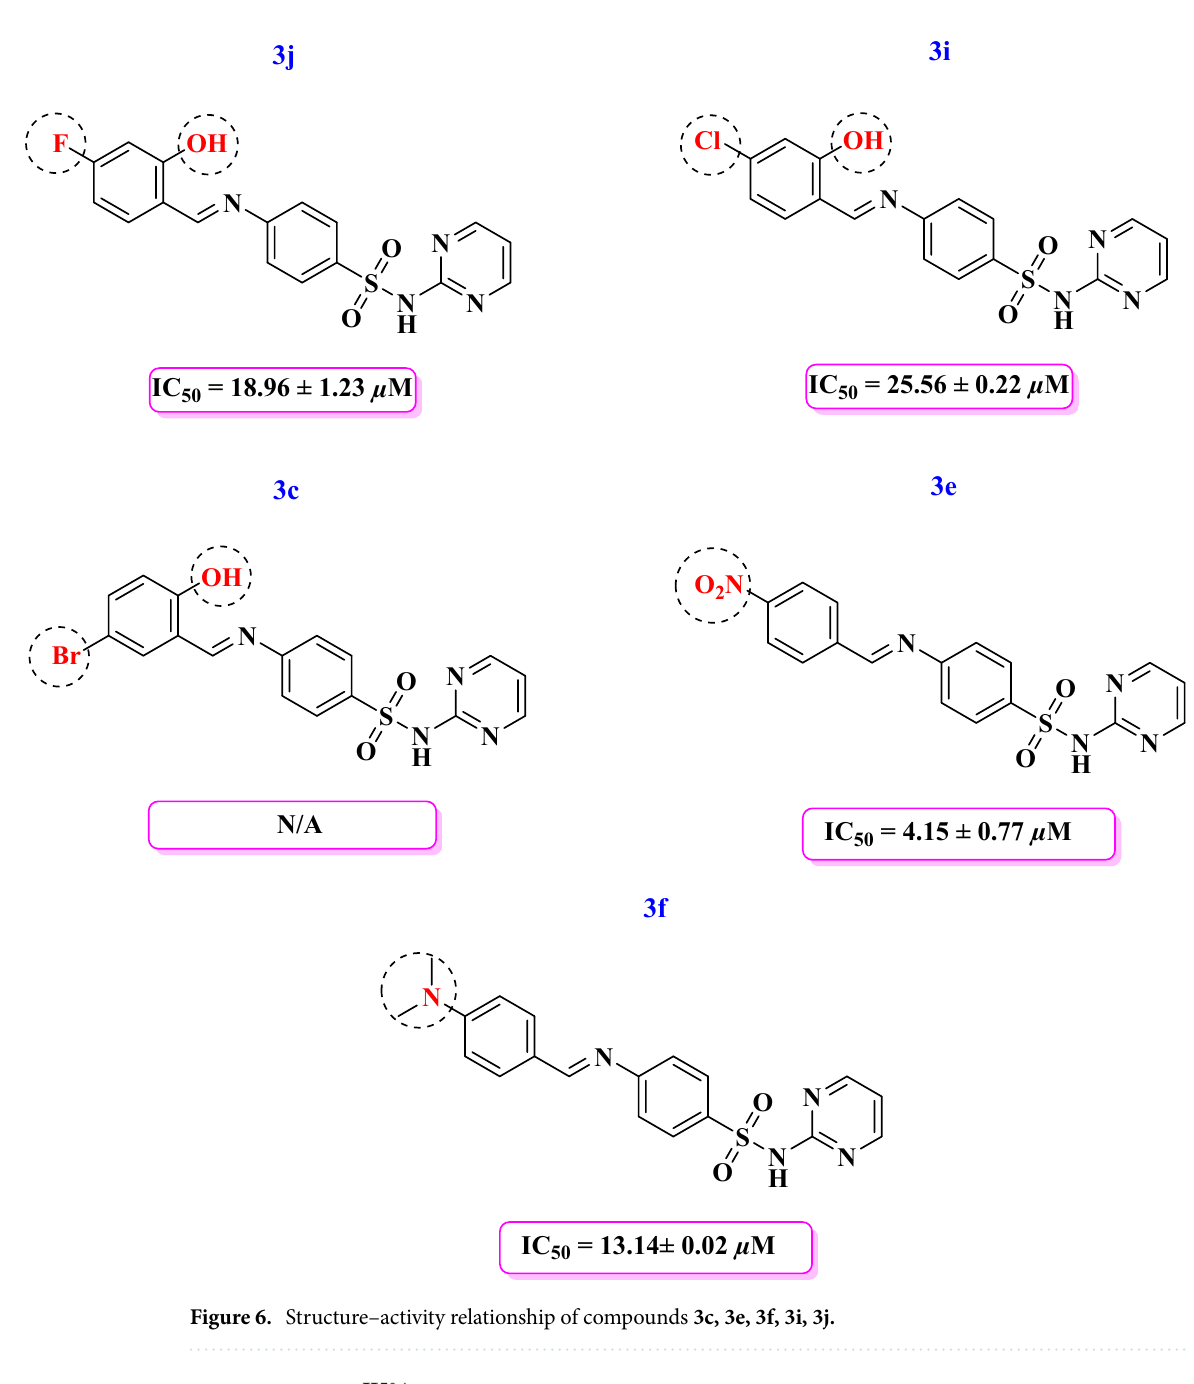
Figure 6. Structure–activity relationship of compounds 3c, 3e, 3f, 3i, 3j.